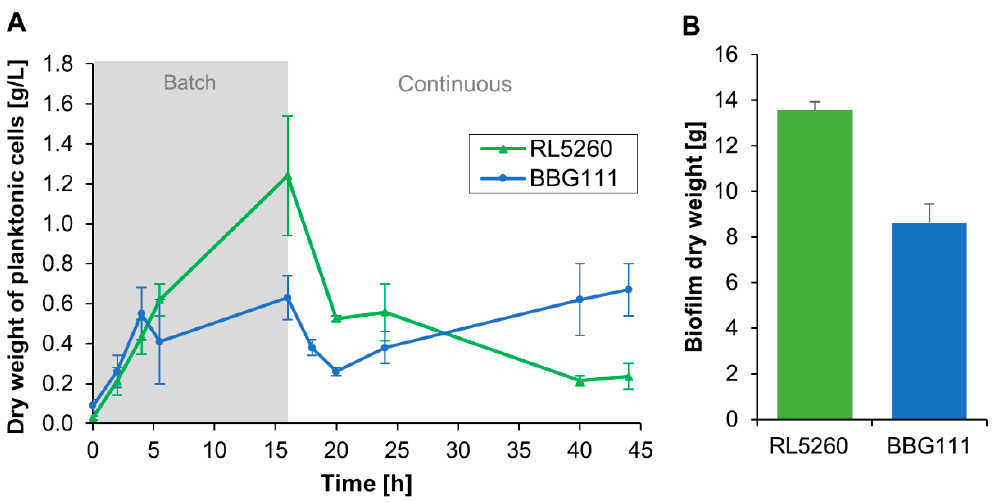
Figure 4. ( A ) Growth curves of planktonic cells and ( B ) amount of adhered dry biomass on the packing tower at the end of the continuous culture measured for each strain in the trickle-bed biofilm reactor. The standard deviation is indicated by error bars.